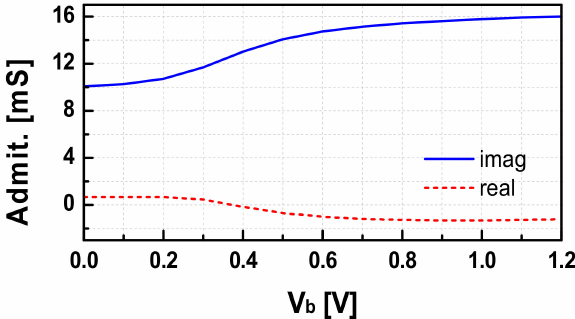
Figure 7. The input admittance of the buffer versus gate voltage bias ( V b1